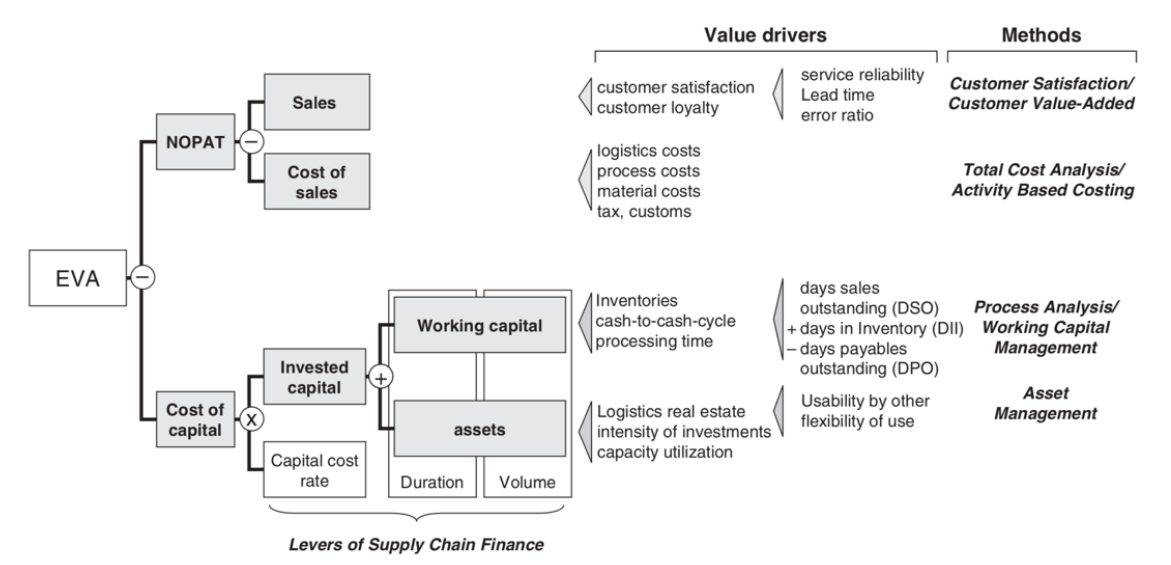
Figure 1 . EVA value driver hierarchy and levers of SCF. (Gomm,